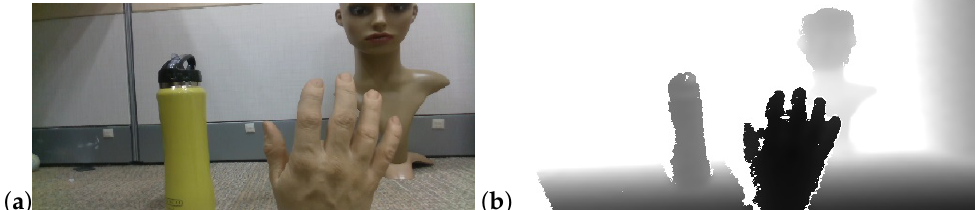
Figure 1. ( a ) RGB image. ( b ) Depth image—darker pixels indicate distances closer to the camera. (Intel RealSense D435).